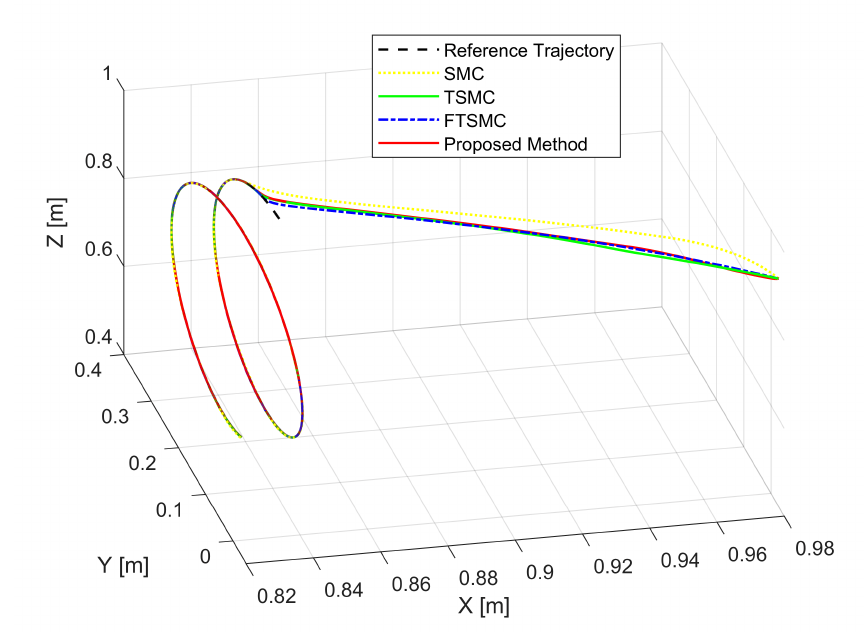
Figure 9. The real trajectories under all controllers versus the desired